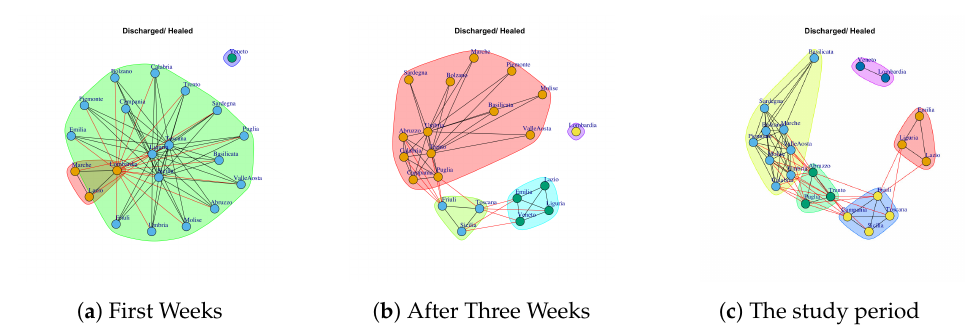
Figure 20. Evolution of Discharged/Healed Network